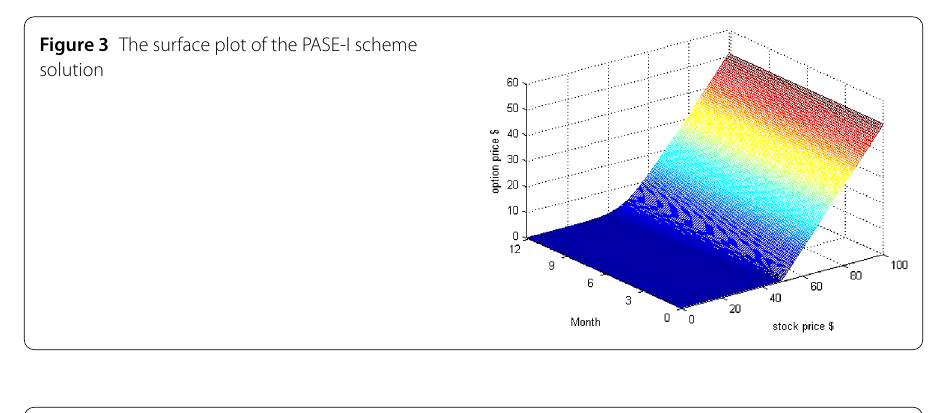
Figure 4 The surface plot of the PASI-E scheme